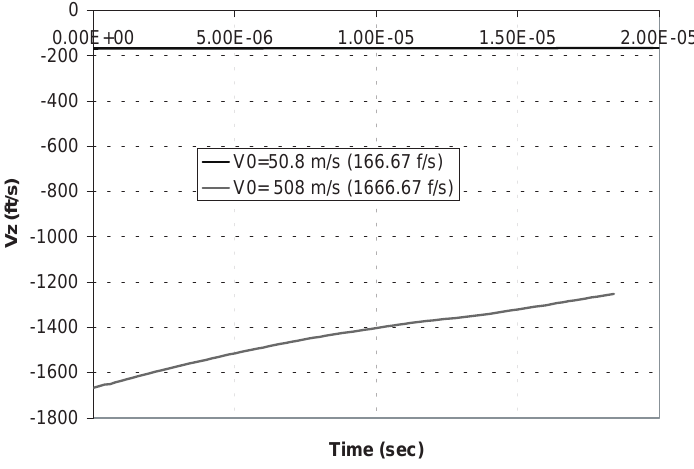
Fig. 14. A comparison of the time history of the z-component of projectile